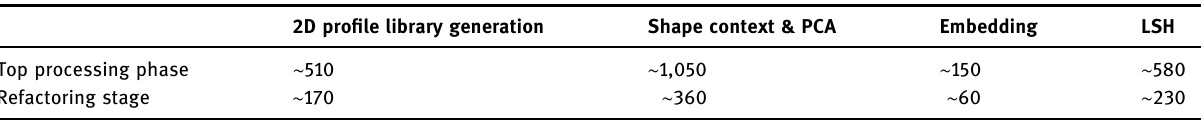
Table 1: Statistical table of attitude reconstruction processing